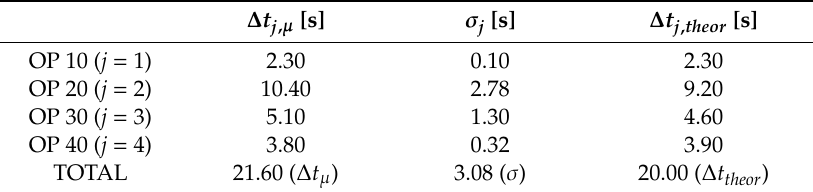
Table 1. Time values for working cycle operations.